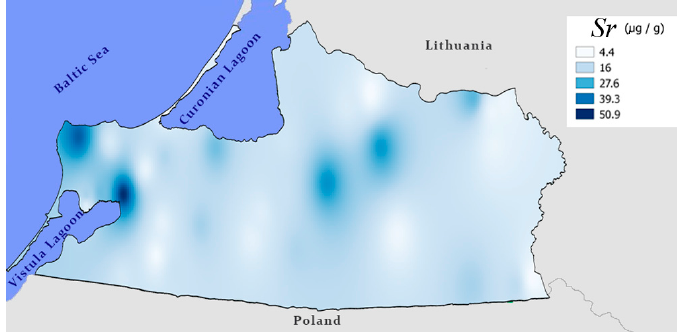
Figure 7. Distribution of strontium in the thalli of H. physodes in the Kaliningrad region, 2010.